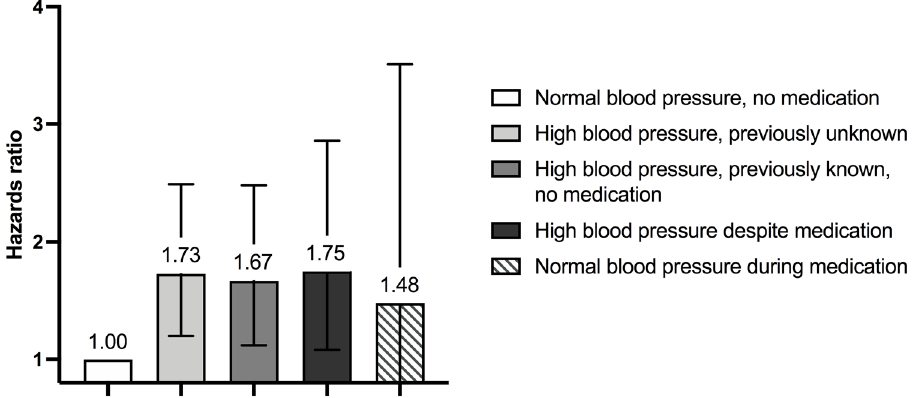
Figure 1. Associations by Cox regression between different categories of baseline arterial hypertension and liver-related outcomes. High blood pressure is defined as measured blood pressure ≥ 140 (systolic) or ≥ 90 (diastolic) mmHg. Error bars reflect 95% confidence